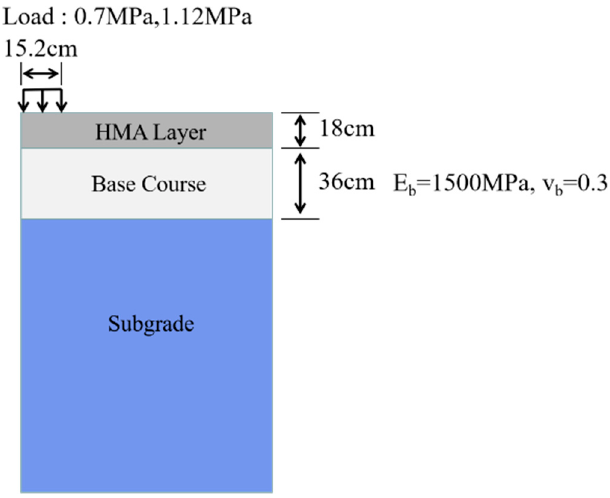
Figure 14. Illustration of pavement structure model and corresponding